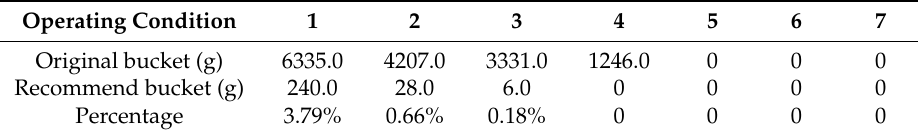
Table 3. The splash water weight under different conditions in the physical model test.